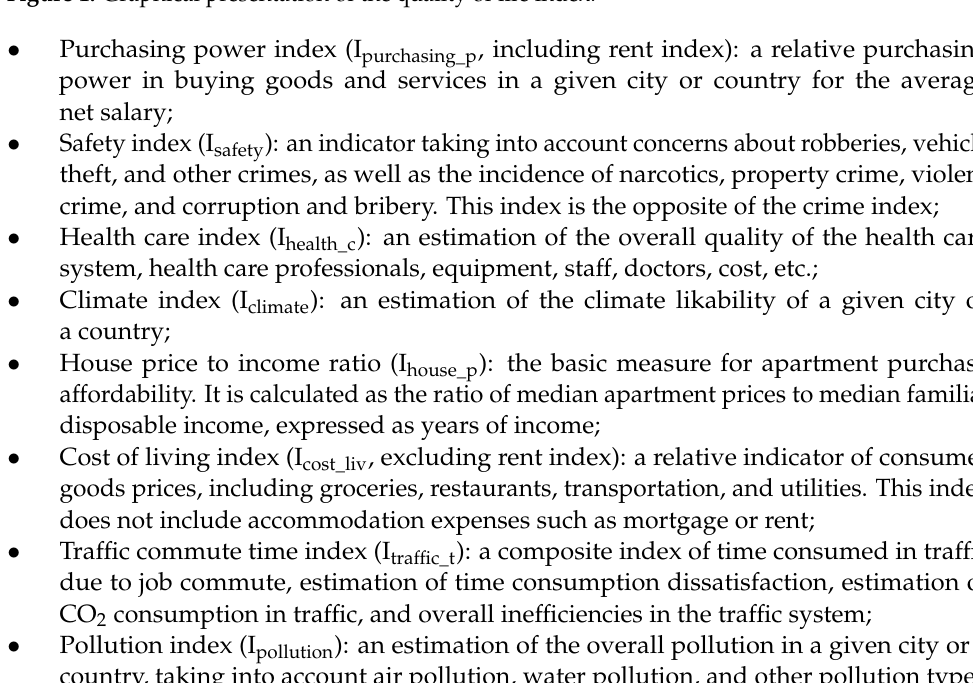
Figure 1. Graphical presentation of the quality of life index.